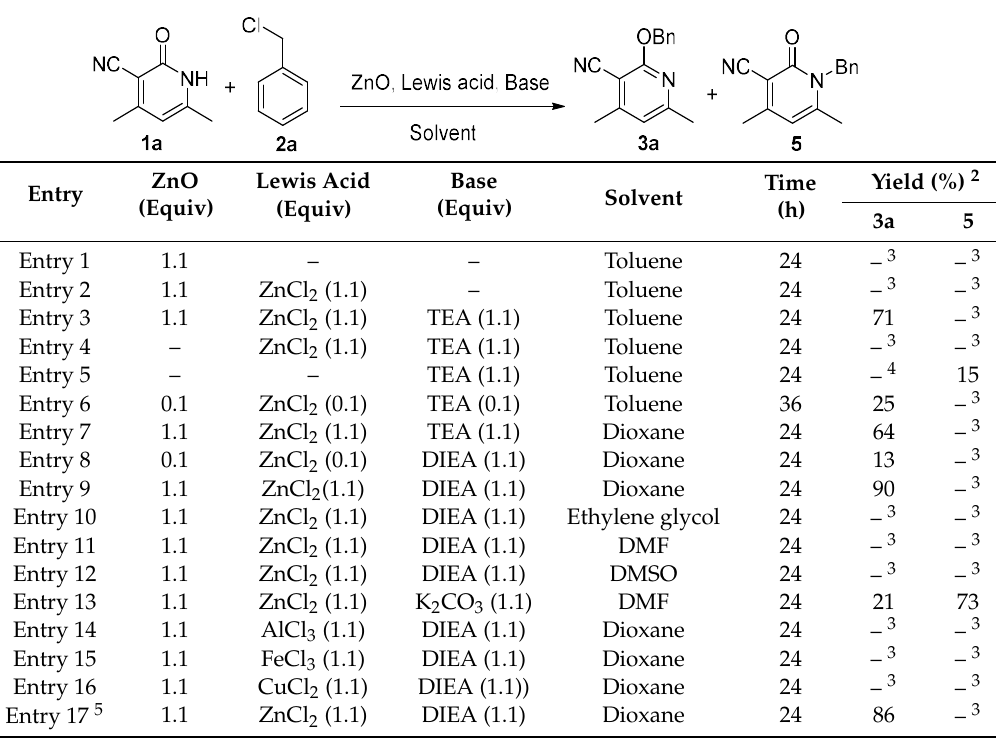
Table 1. Optimization of the reaction conditions for the O -benzylation of 1a and 2a 1 .